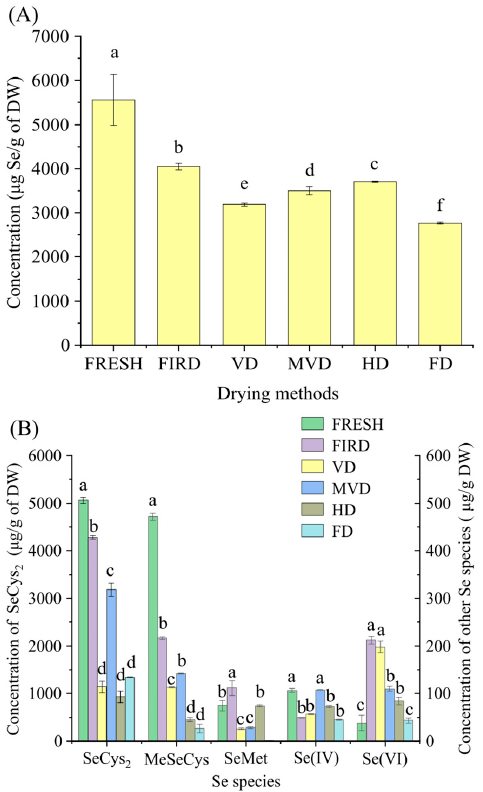
Figure 1. The Se ( A ) and Se species ( B ) concentration of fresh and dried CVLs. Different letters represent significant differences ( p < 0.05). FRESH: CVLs of fresh samples, FIRD: CVLs of far-infrared drying; VD: CVLs of vacuum drying; MVD: CVLs of microwave vacuum drying; HD: CVLs of hot air drying; FD: CVLs of